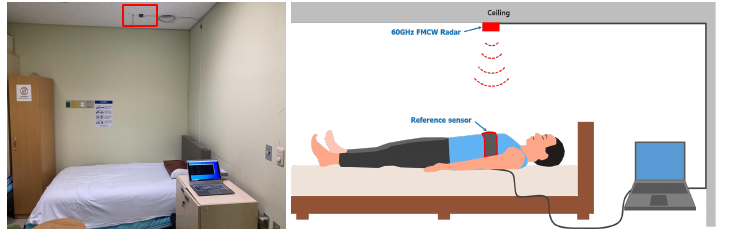
Figure 1. Photo and illustration of radar (red box) setup for respiratory signal monitoring.